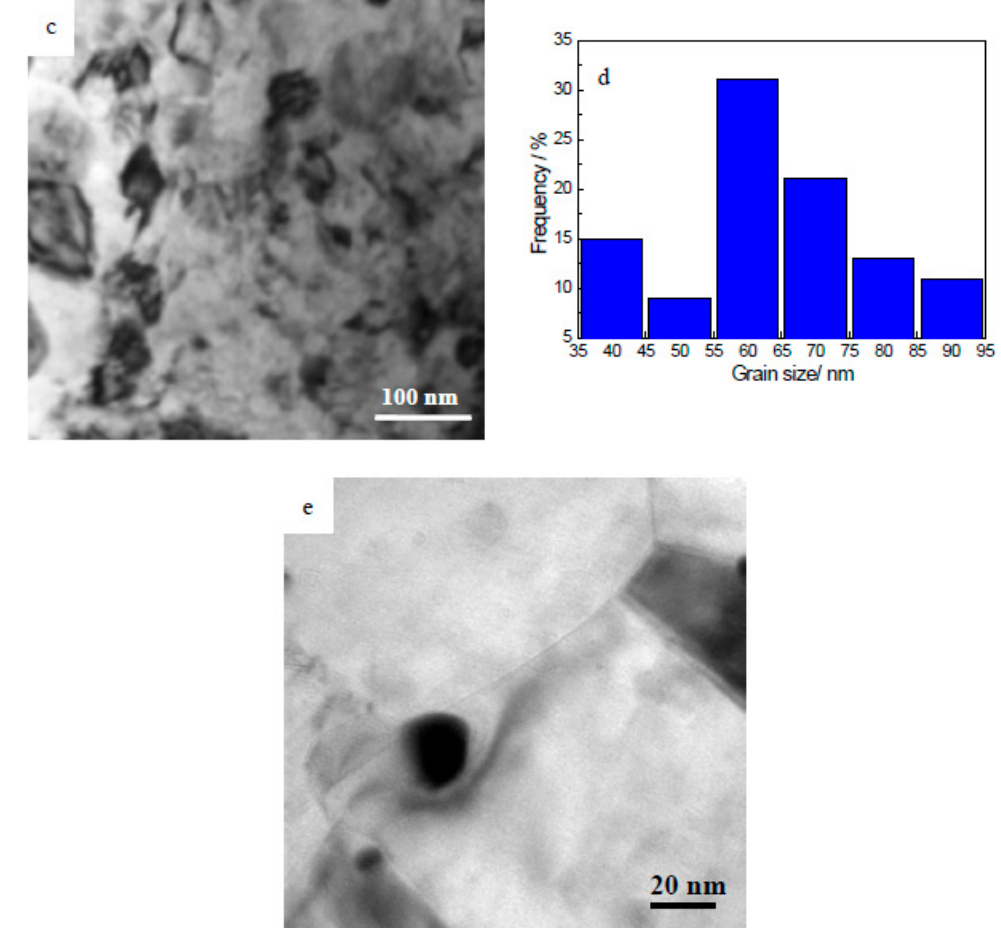
Figure 5. TEM images of MA ‐ ed Cu ‐ Nb powders annealed at 900 °C. ( a ) 1 h, BF image, nanocrystalline Cu grains; ( b ) 1 h, Cu grain size distribution histogram; ( c ) 3 h, BF image, nanocrystalline Cu grains; ( d ) 3 h, Cu grain size distribution histogram; ( e ) 3 h, BF image, Nb nanoparticles.